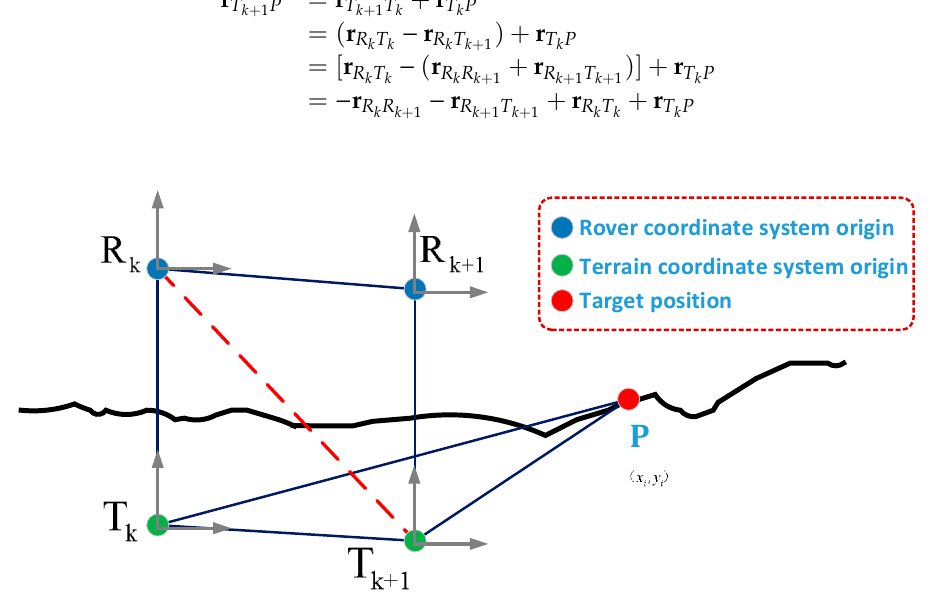
Figure 2. Positional relationship at different times.